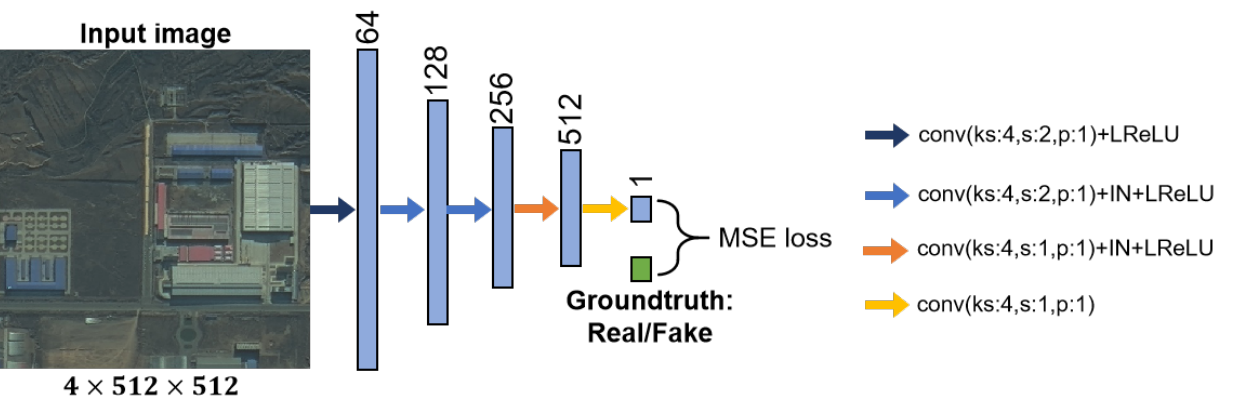
Figure 6. The architecture of the discriminator. LReLU and IN correspond to leaky rectified linear unit and instance normalization respectively. We use mean squared error loss instead of